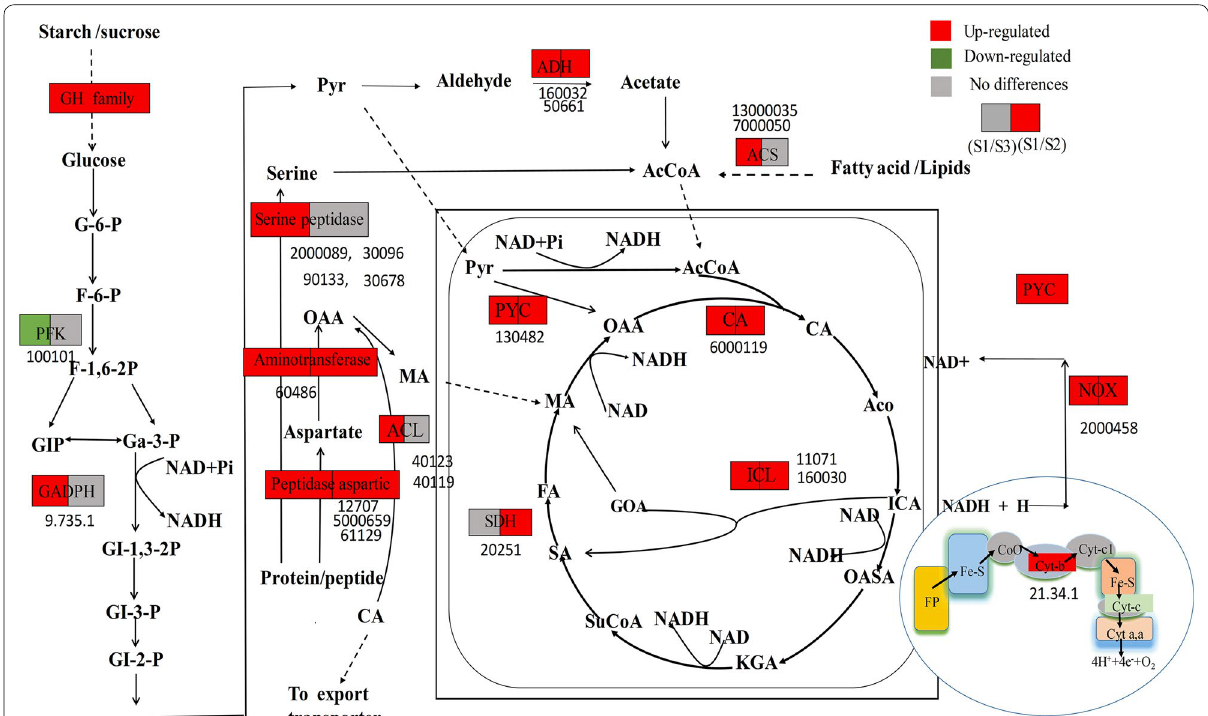
Fig. 5 Transcription level regulation of genes involving CA production in three different A. niger at 10 h. Upregulated, downregulated, and no differ‑ entially expressed genes involving CA production are highlighted in red, green, and gray color, respectively. Comparative transcriptomic differences of strain YX‑1217 versus ATCC 1015 ( S 1/ S 3) and strain YX‑1217 versus YX‑1217G ( S 1/ S 2) at 10 h are exhibited, respectively, in squares. PFK 6‑phospho‑ fructokinase, GADPH glyceraldehyde‑3‑phosphate dehydrogenase, PYC pyruvate carboxylase, ACS acetyl‑coA synthetase, ADH alcohol dehydroge‑ nase, CS citrate synthase, ICL isocitrate lyase, SDH succinate dehydrogenase, ACL ATP‑citrate lyase, NOX NADH/NADPH